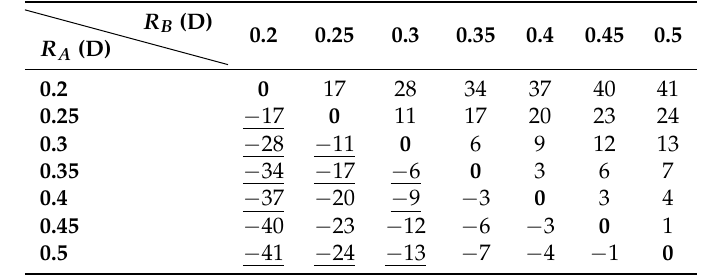
Table 1. Angle (degrees) between the vortex dividing lines in each helical geometry—a positive value denotes an anti-clockwise rotation, following the convention used in Jones et al. [28]. The helical radius of the first geometry is denoted R A and that of the second R B . The combinations selected for investigation are underlined.